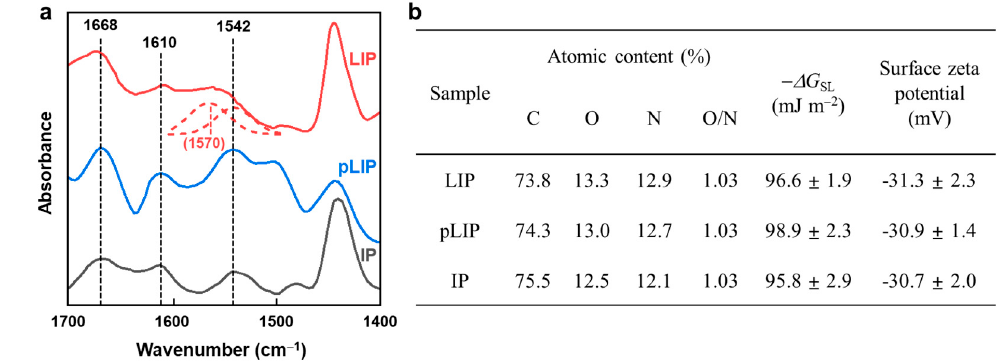
Figure 8. Physicochemical properties of the fabricated membranes. ( a ) FT-IR spectra and ( b ) XPS atomic content, intrinsic surface hydrophilicity ( − ∆ G SL ), and surface zeta potential of the LIP, pLIP, and conventional IP membranes.